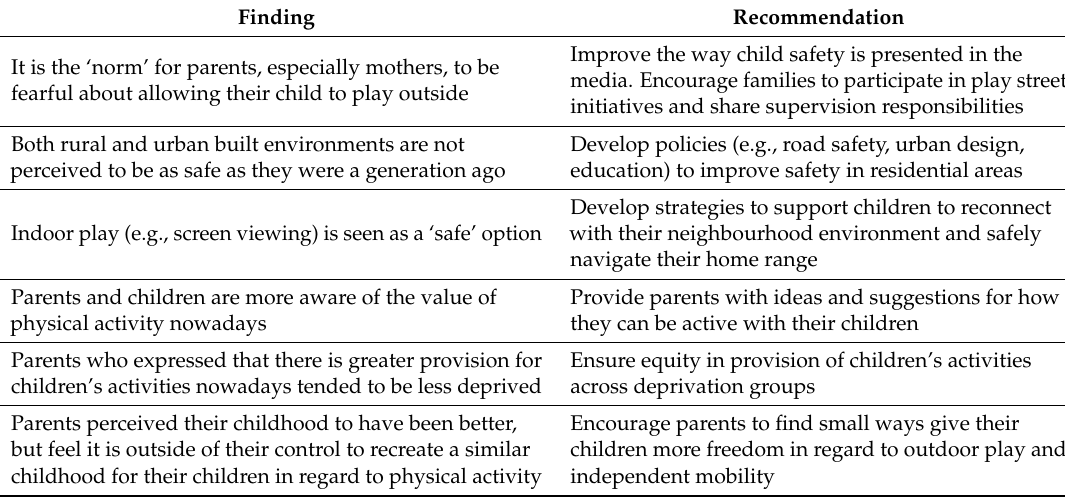
Table 2. Key findings and recommendations for behaviour change